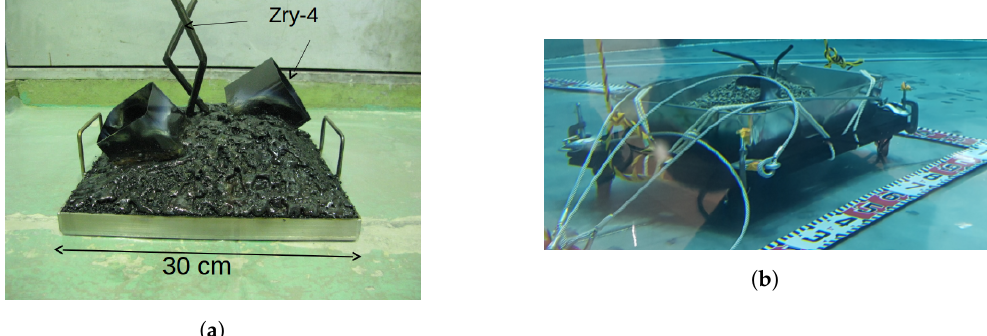
Figure 2. Simulated debris placed at the bottom of the tank as seen in-air, ( a ), before simulated sludge was added and from a submerged camera after deployment with sludge, ( b ).